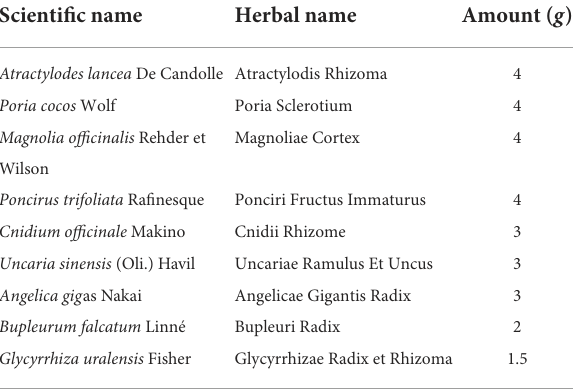
TABLE 2 Composition of Ukgansan *